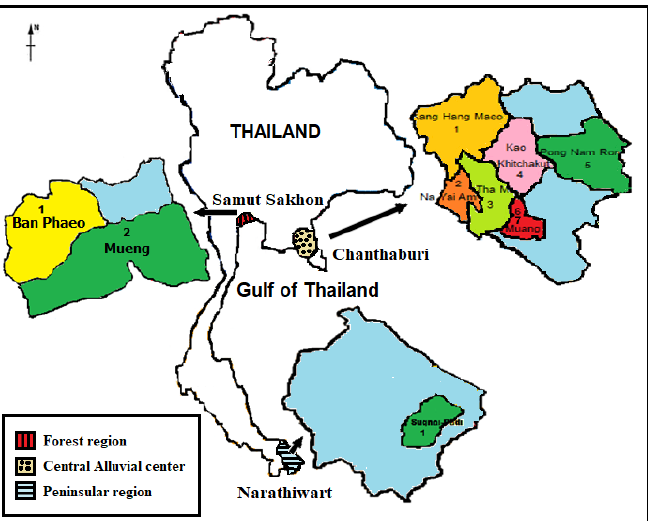
Figure 1. The map of Samut Sakhon, Chanthaburi, and Narathiwat provinces showing the location of the study sites.